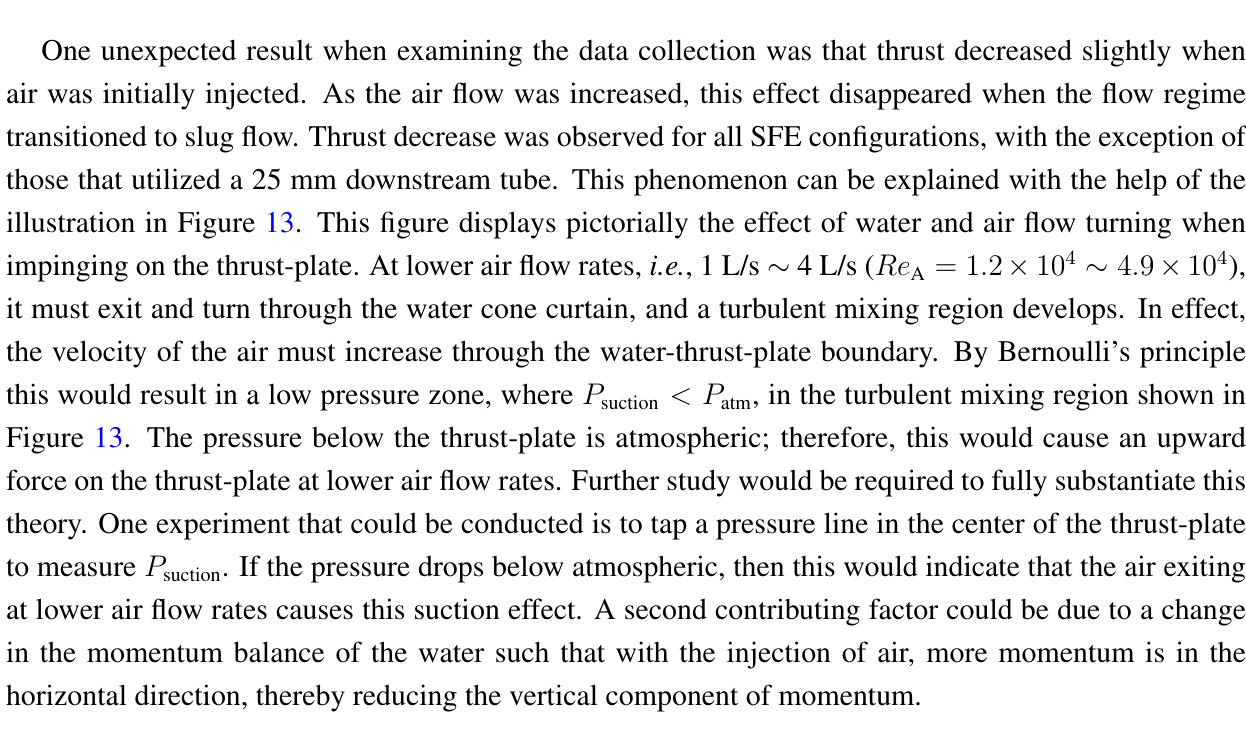
Figure 13. Suction